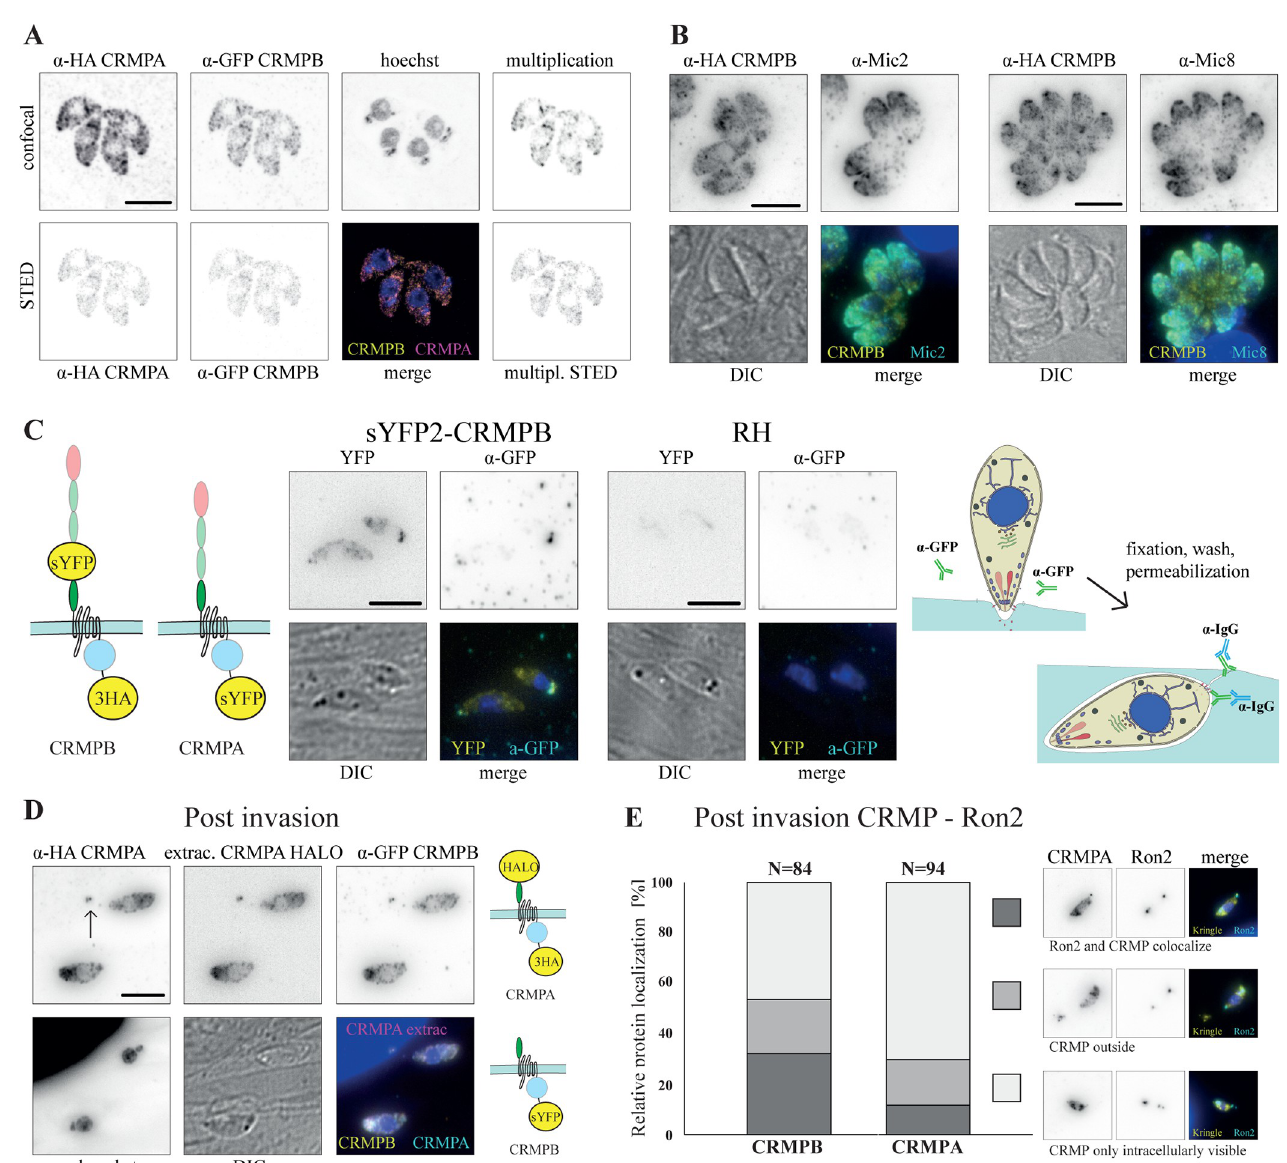
Fig 2. Subcellular localization of CRMPB and CRMPA using STED microscopy. ( A) Colocalization of CRMPA and CRMPB. RH-CRMPA-3HA floxed CRMPB-sYFP2 was stained with for HA (Star635P) and sYFP2 (Atto594). A colocalization map using the multiplication of both signals shows a high degree of colocalization within the whole cell. A parasite line with swapped tags shows comparable localization (S4 Fig). ( B) Colocalization of RH-CRMPB-3HA floxed stained for HA (Star635P) with micronemal proteins MIC2 and MIC8. ( C) A pulse invasion assay of parasites with extracellular tagged CRMPB (RH- sYFP2-CRMPB-3HA floxed CRMPA-sYFP2) was performed in the presence of α -GFP antibodies. Post-invasion parasites were fixed, permeabilized, and the a- GFP antibody was visualized. See schematics of experimental design on the right. YFP signal is all CRMPs of the parasite. ( D) Parasites with extracellular CRMPA Halo (RH-Halo-CRMPA-3HA floxed CRMPB-sYFP2) were labeled with Halo-Janelia 646 and fixed after pulse invasion in the presence of proponol. The putative invasion site is marked with an arrow. Tagging schematics of experimental design on the right. ( E) Pulsed invasion of RH-CRMPB-3HA floxed CRMPA-sYFP2 RON2-SNAP and RH-CRMPA-3HA floxed CRMPB-sYFP2 RON2-SNAP after labeling with SNAP-Cell. Relative position of the basal RON2 signal at the site where the parasitophorous vacuole closes and the CRMP signal were scored as colocalization, CRMP outside of RON2, or only internal CRMP signal (see also S1 Data). Scale bars are 5 μ